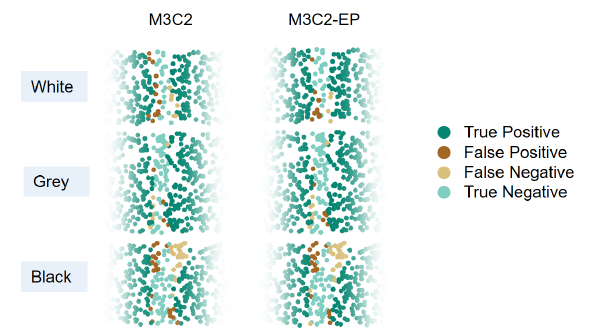
Figure 14. Difference between change estimated from the tachymetry measurements and the M3C2 change quantification. Differences up to 5mm appear, especially in the black surface. truth for significance of the change, as presented in Section 2.3. Table 4. Comparing the state-of-the-art M3C2 model with ours shows very similar values.